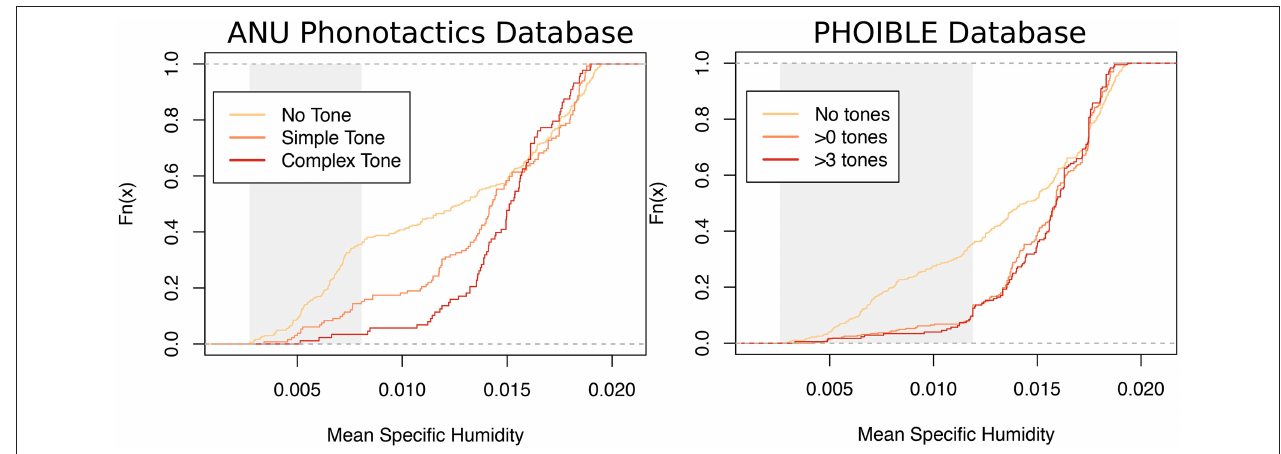
FIGURE 3 | The cumulative distribution of humidity for different categories of language (no tones, < 3 tones, 3 or more tones) from the ANU phonotactics database (left) and the PHOIBLE database (right) . Shaded areas represent the bottom quartile of the humidity distribution (25th percentile).